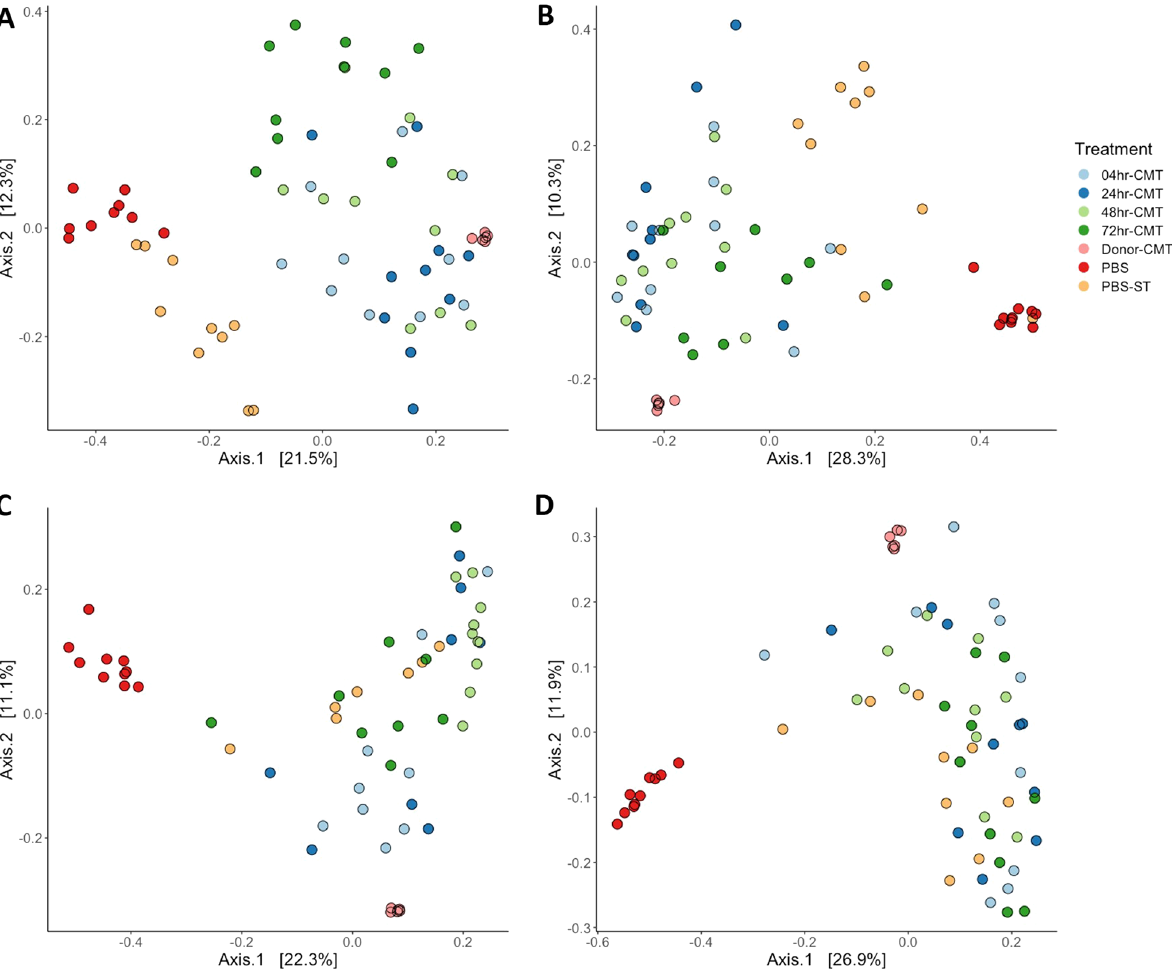
Fig. 6 Effect of timing on patterns of community composition in CMT birds compared to PBS birds. Principle coordinate of Bray-Curits dissimilarity plots show distinct differences between the composition of CMT groups compared to PBS groups. At 7-dph ( A ) and prior to infection with ST4/74 the CMT groups cluster closely with the donor material whilst the PBS groups cluster closer together. From 3-dpi ( B ) shifts in the composition of the PBS-ST group but not the PBS group were observed. At 7-dpi ( C ) the PBS-ST groups had fully shifted to compositions similar to CMT groups and by 14-dpi ( D ) separation of the PBS group form the CMT and PBS-ST groups was most